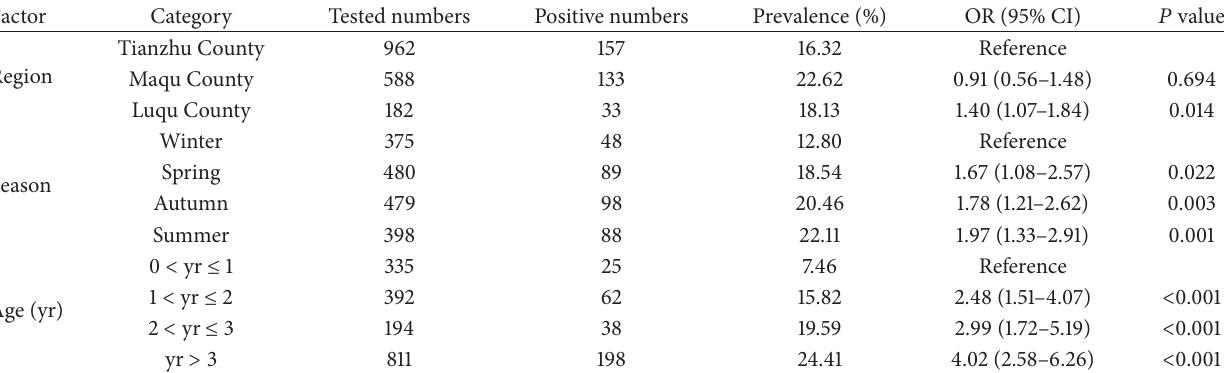
Table 4: Odds ratios for ages, seasons, and geographical origin of Tibetan sheep are taken as risk factors for Chlamydia abortus seroprevalence in Tibetan